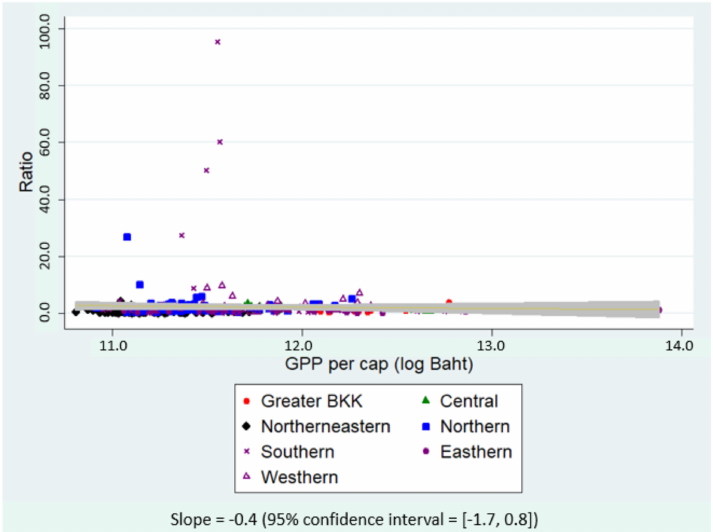
Figure 3. Scatter plot between the ratio of insured migrants to formal-sector migrants and GPP per capita,